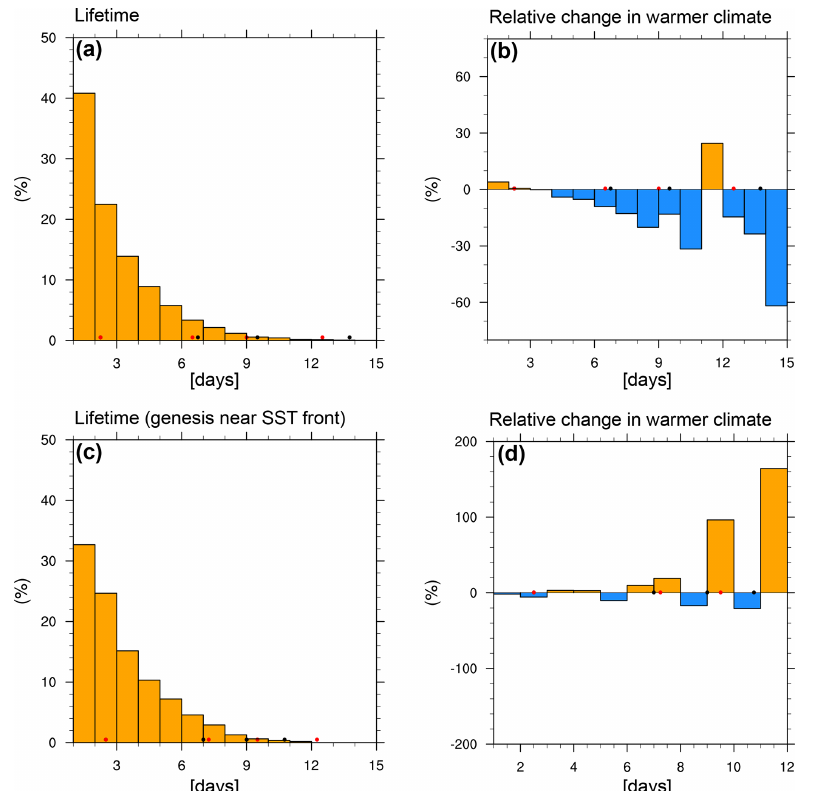
Figure 8. Frequency distribution of lifetimes of extratropical cyclones for (a) all cyclones (NH and SH) and (c) cyclones with genesis in the vicinity of the SST front in the control simulation. On the lower axes, dots indicate the median and the 95th, the 99th, and the 99.9th percentiles for the control (black) and + 4K (red) simulations. (b, d) Relative change of the distributions shown in (a) and (c) in the + 4K simulation. Note that the large relative change for the high percentiles results from the low number of cases in these bins. Note the different scaling in (b) and (d)